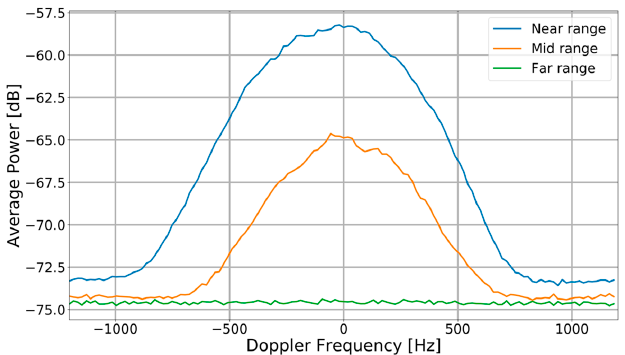
Figure 26. Average Doppler spectrum of the linearly acquired data estimated in near, mid and far range. The ambiguities cause a variation in the average power in the noise region of the spectrum. From Error! Reference source not found. , it is clear that due to high incidence angle, the backscatter power received in far range is very low. It can also be said that in far range, the intensities are more Rayleigh distributed. This is evident from Error! Reference source not found. c